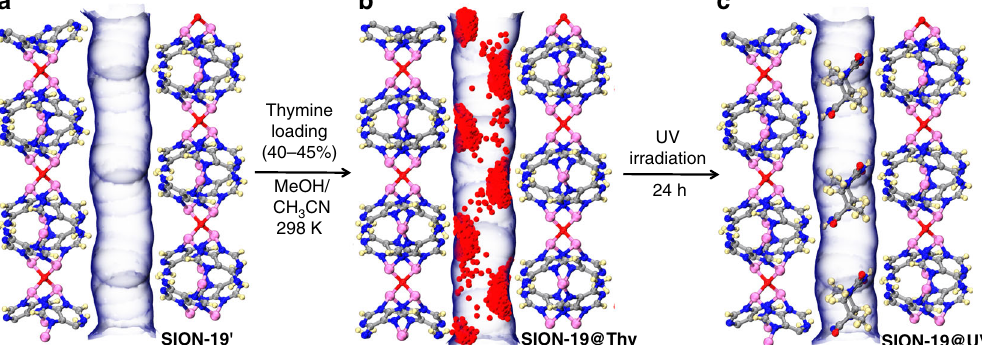
Fig. 4 Schematic representation of thymine loading, location, and dimerization within SION-19 ′ . a 1-dimensional base-pore surface for SION-19 ′ prepared using HOLE2. b Thy snapshots (red dots) from an MD trajectory of 44% thymine loading in the base pore of SION-19. Here, Ade acts as a structure directing agent that ‘ lock ’ Thy molecules into positions close enough to another Thy molecule for photodimerization to occur. c DFT optimized positions of Thy<>Thy dimers arising from a 44% loading of Thy. Atom color code: pink, Zn; red, O; blue, N; gray, C; light yellow, H